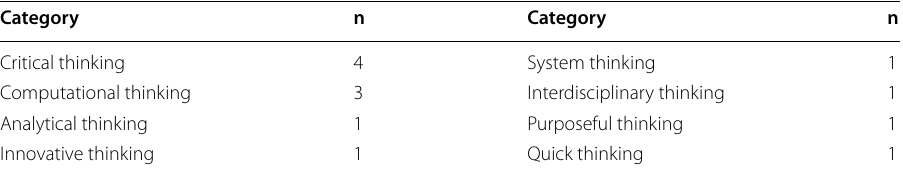
Table 8 Categories under ‘thinking’ major theme Category